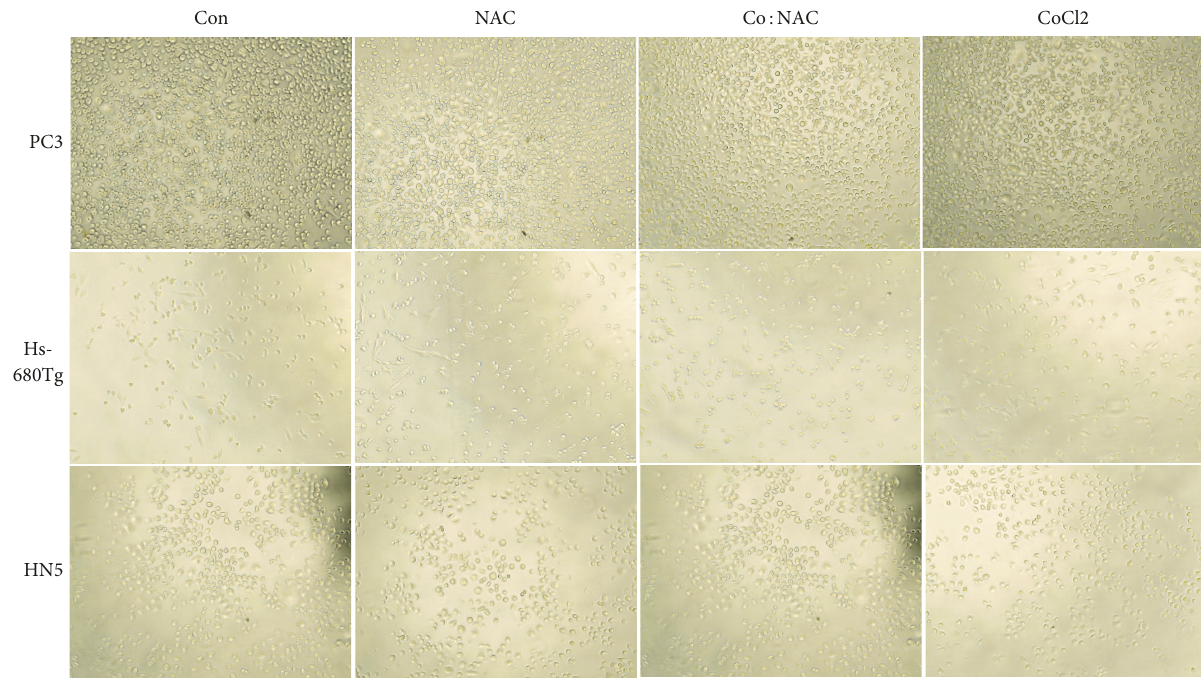
Figure 2: Cell morphology after various treatment conditions. Human prostate cancer cells (PC3), human normal tongue cells (Hs-680Tg), and human head and neck cancer cells (HN5) were treated with the greatest clinical exposure concentration of the novel MRI Co: NAC positive-contrastagentforC4markeroritscomponents(1%[w/v]CoCl 2 ⋅ 6H2O,2%[w/v]N-acetylcysteine(NAC),orthecombinedCo : NAC solutions (1%: 2% [w/v])). At 90 minutes after treatment, cell morphology pictures were taken with a bright field Evos XL core microscope (AMEX 1000, Life Technologies, Carlsbad, CA, USA) at × 10 magnification. Controls (Con) were untreated